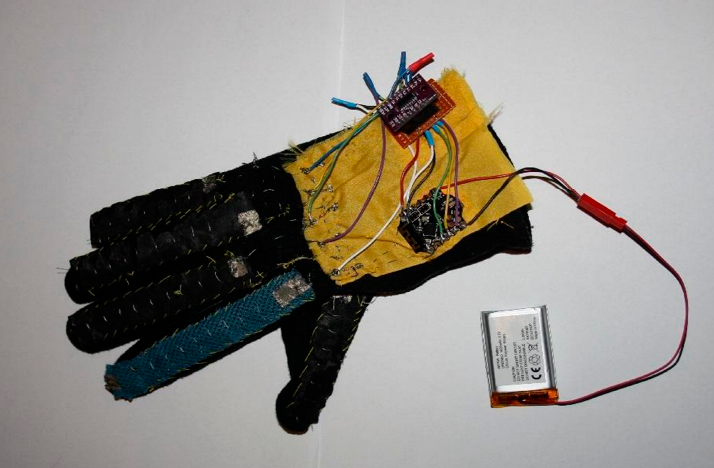
Figure 1. The photo of two sides of the materials (front and back) used for the research: ( a ) Velostat, ( b ) Cordura, ( c ) Goretex membrane.